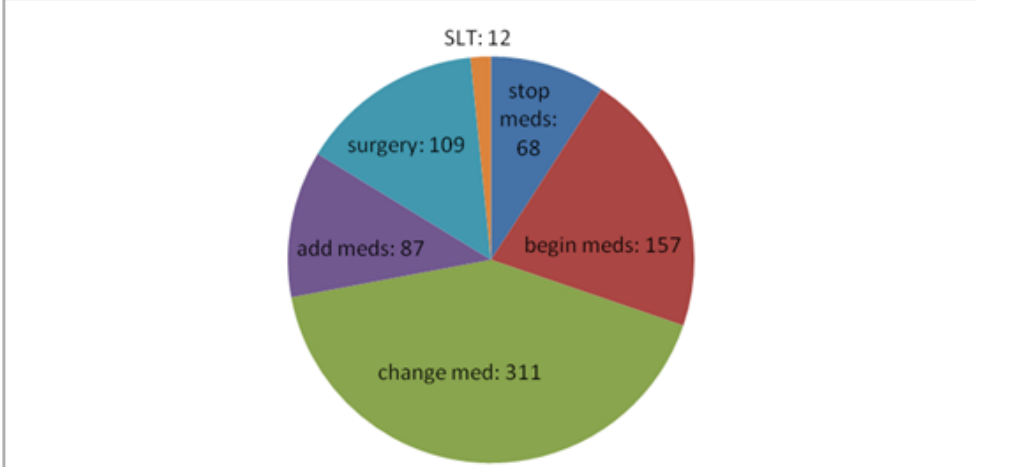
Figure 3. Alterations of the therapy after IOP monitoring—numerical distribution. In total, 756 (50.4% of 1500) patients needed no changes regarding their therapeutic management. Of these, 464 (30.9% of all 1500, 61.4% of 756 patients needing no therapeutical change) remained in observation in order to attend to any glaucoma manifestations. A total of 292 patients already on antiglaucoma medication (19.5% of 1500, 38.6% of 756) remained with the same medication, which was considered satisfactory, according to IOP measurements.